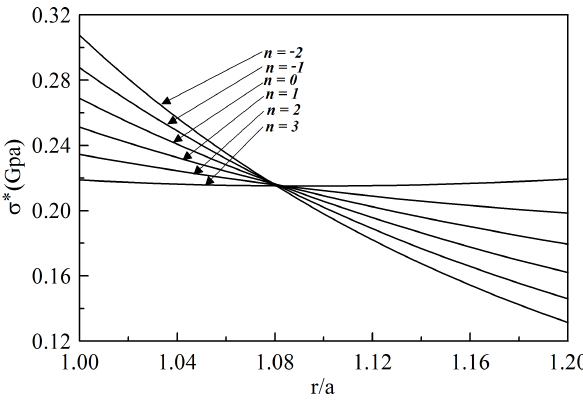
Figure 15: Radially distributed von-Mises stress